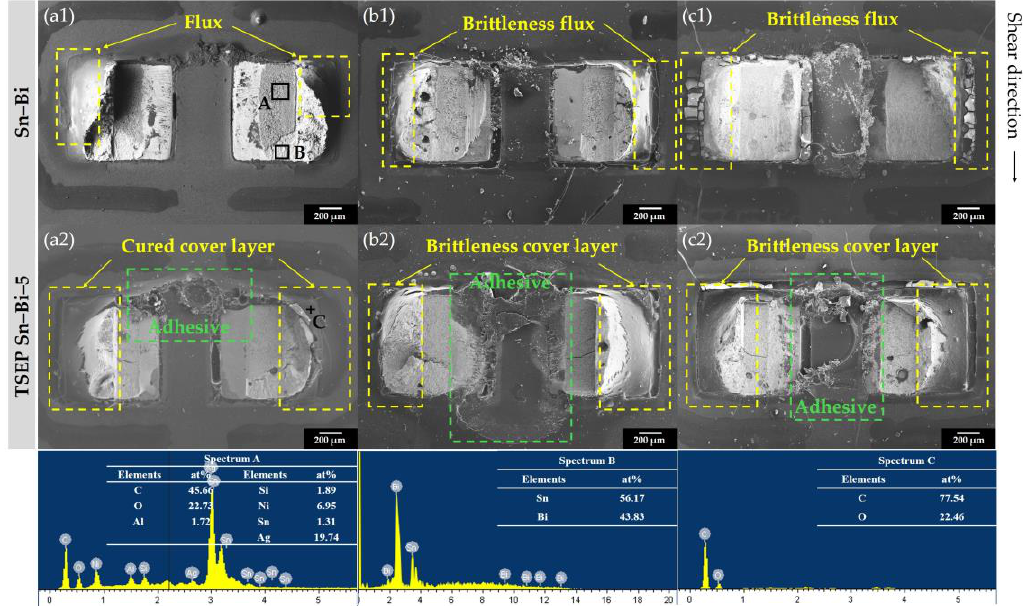
Figure 8. Fracture morphology of Sn – Bi and TSEP Sn – Bi-5 solder joints: ( a1 , a2 ) Solder joints after soldering; ( b1 , b2 ) Solder joints after 1000 h; ( c1 , c2 ) Solder joints after 1000 cycles.